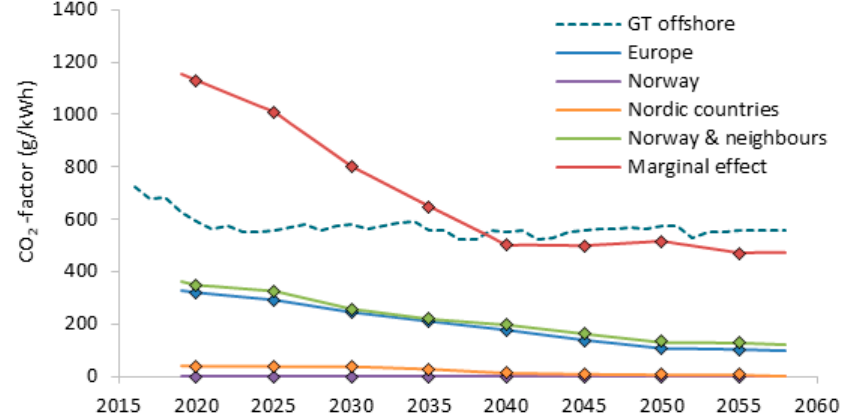
Figure 11. CO 2 -factors for the NP scenario calculated with the different approaches selected and adjusted for offshore supply. The dashed line is the CO 2 -factor related to offshore gas turbines.